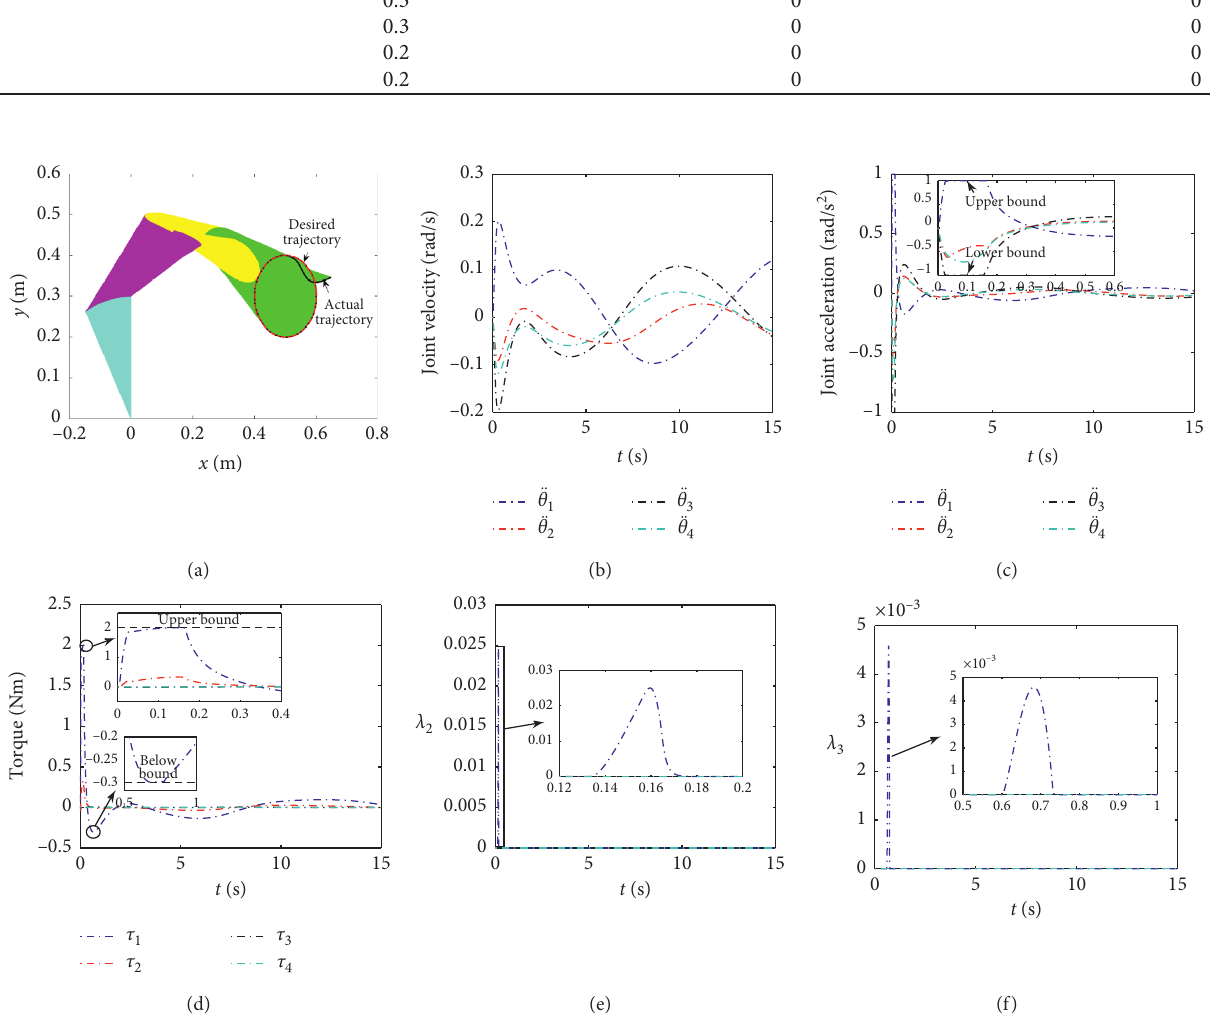
Figure 5: Simulative results achieved by equation (10) when the manipulator is expected to follow a circle path. (a) Tracking result. (b) Joint speed profiles. (c) Joint acceleration profiles. (d) Joint torque profiles. (e) State variables λ